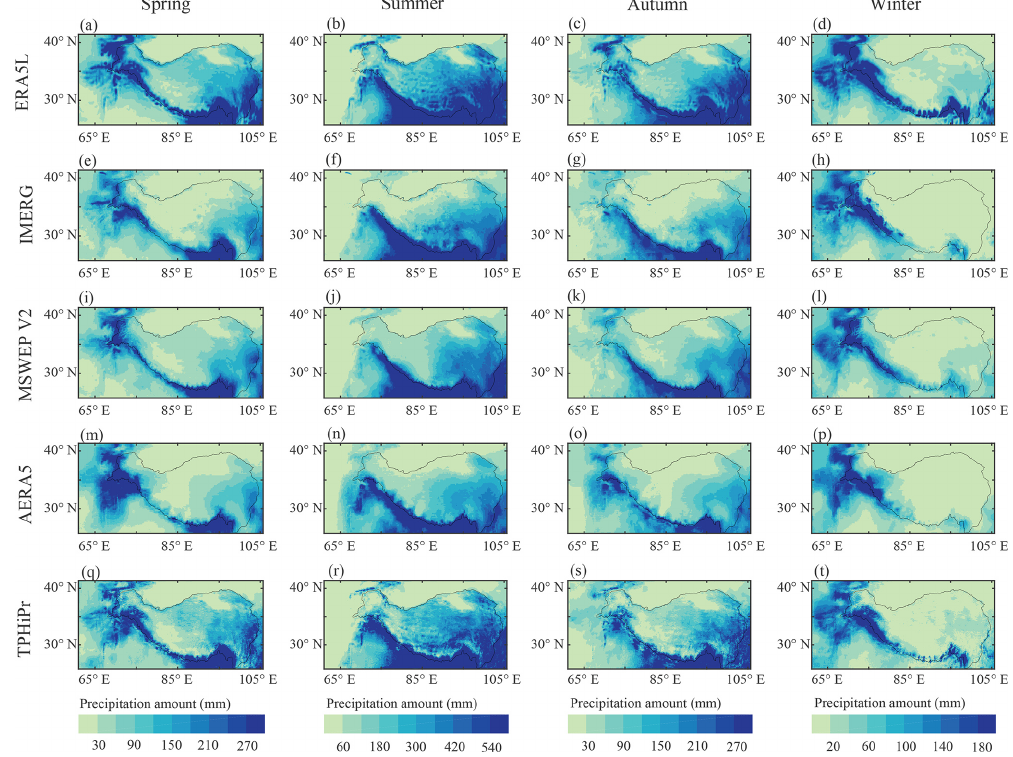
Figure 7. Spatial patterns of average seasonal precipitation from ERA5L (first row), IMERG (second row), MSWEP v2 (third row), AERA5 (fourth row) and TPHiPr (fifth row). The precipitation is averaged over the period from 2008 to 2015.